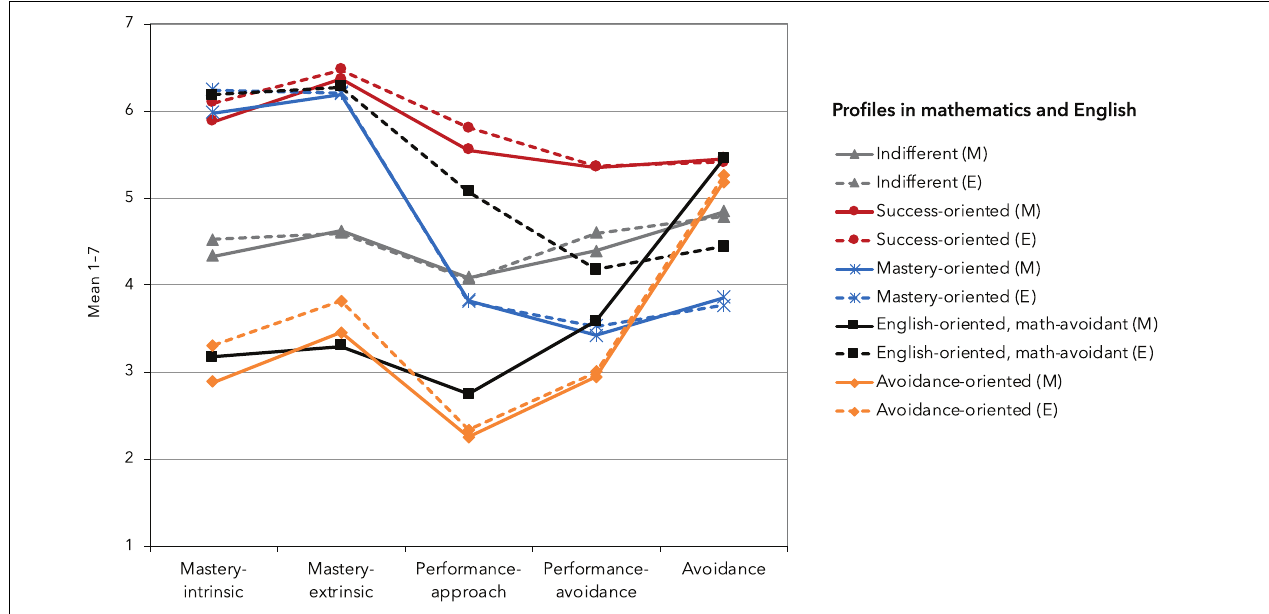
FIGURE 1 | Achievement goal orientation profiles of the five groups in mathematics and English. Latent profile analysis was based on 10 clustering variables, that is, five achievement goal orientations in two subjects. The solid lines represent profiles in mathematics (M), and the broken lines represent profiles in English (E).